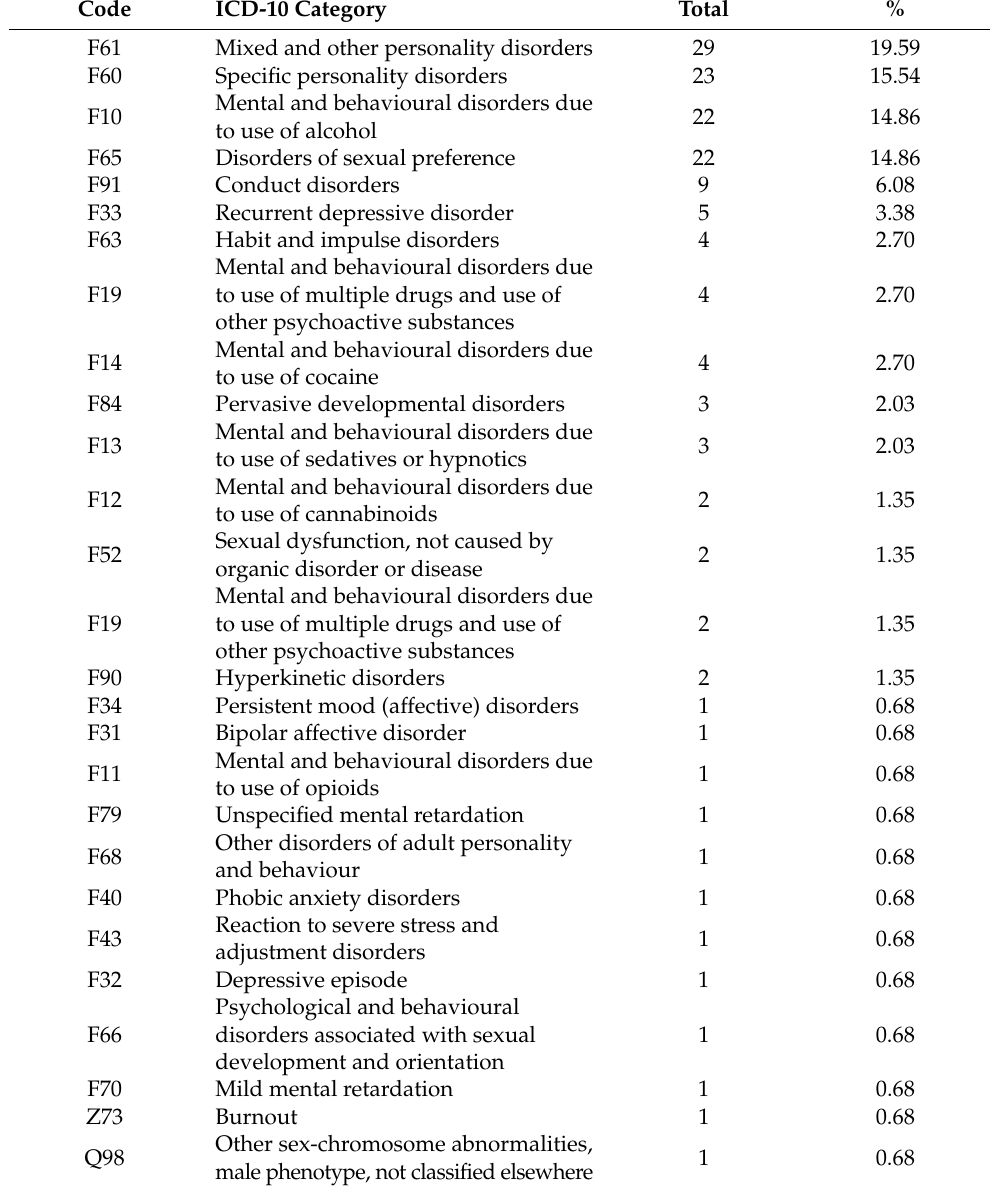
Table 1. Diagnoses of the study population (several diagnoses per prisoner